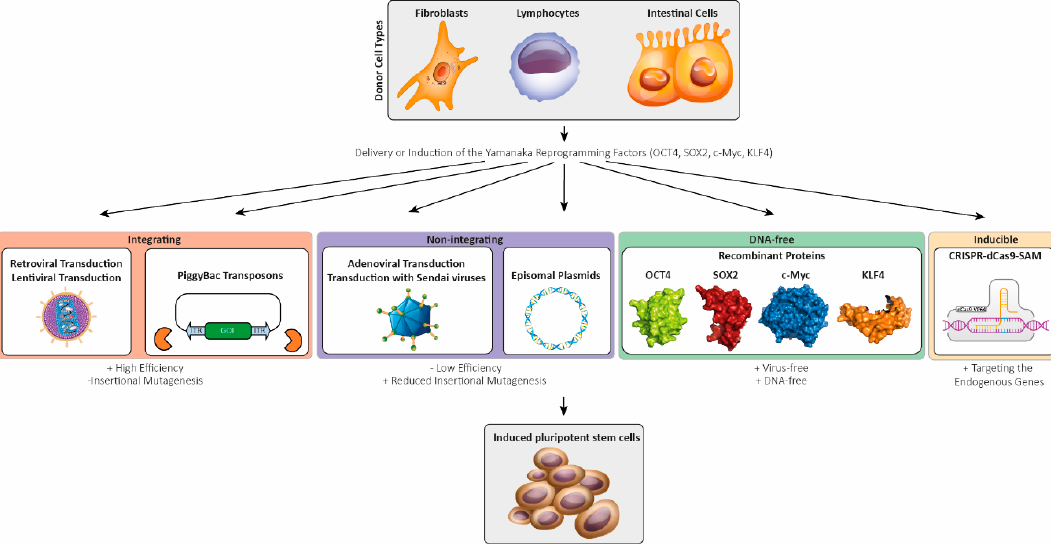
Figure 2. Schematic overview about different delivery methods of the Yamanaka factors into somatic primary cells for reprogramming (sub-figures for the cell types and viruses were licensed from shutterstock.com).